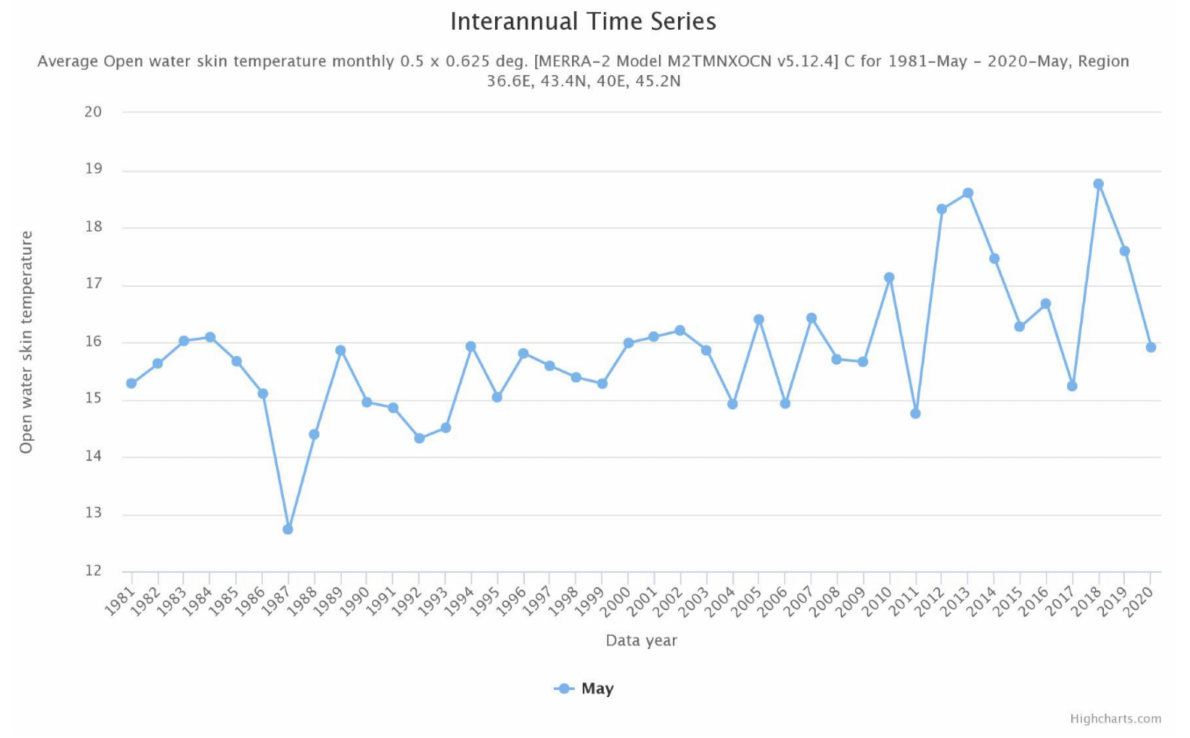
Figure 6. Interannual variability of the sea surface temperature in the northeastern Black Sea in May from 1981–2020 based on the MERRA-2 M2TMNXOCN V5.12.4 Model.